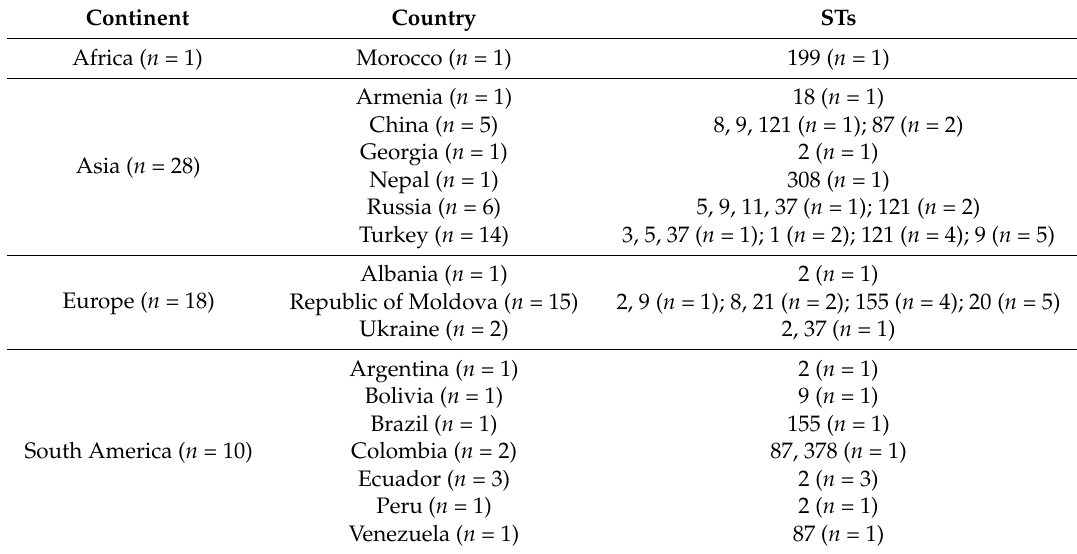
Table 1. Origin of Listeria monocytogenes isolates assigned to sequence types